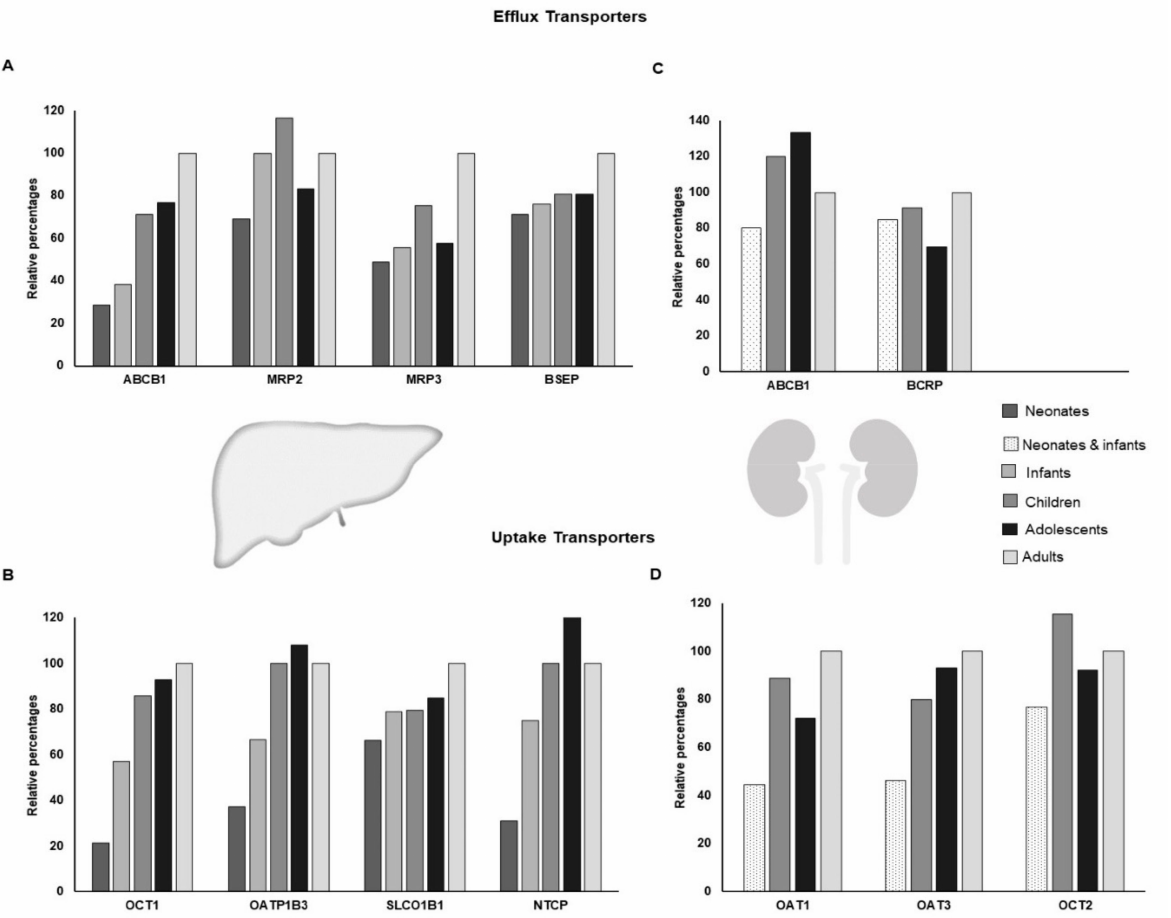
Figure 2. The differential expression of some of the key hepatic ( A , B ), and renal ( C , D ) transporter proteins. The y -axis of the bar chart denotes percentage of protein expression in comparison to adult levels. The data were combined and adopted from Prasad et al., 2016 and Cheung et al., 2019